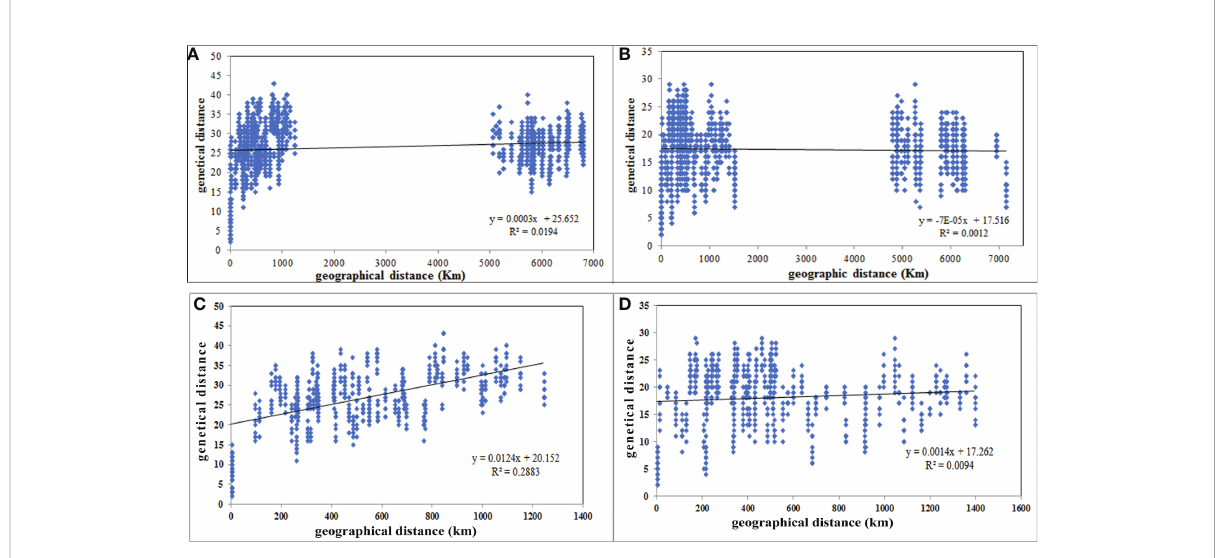
FIGURE 3 Scatterplot of pairwise genetic distance versus geographical distances (km) of 16 A retro fl exus (A) , 17 C . album (B) , 12 iranian A retro fl exus (C) and 13 C . album (D) populations based on “ Isolation by Distance ”